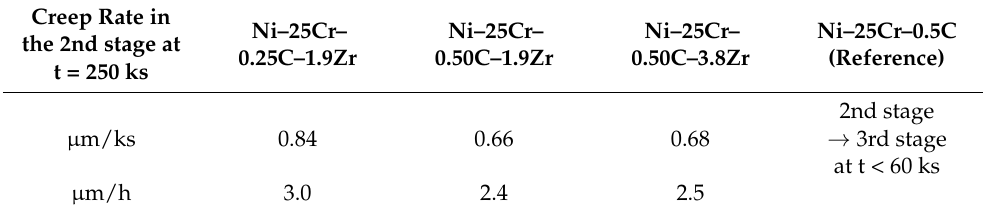
Figure 2. The creep deformation curves of the three Zr–containing alloys in comparison with the Ni–25Cr–0.50C ternary alloy; “NZ1”, “NZ2”, and “NZ3” are the Ni–25Cr–0.25C–1.9Zr, Ni–25Cr– 0.50C–1.9Zr, and Ni–25Cr–0.50C–3.8Zr alloys, respectively. Table 4. Quantitative data characterizing the creep deformation of the alloys.